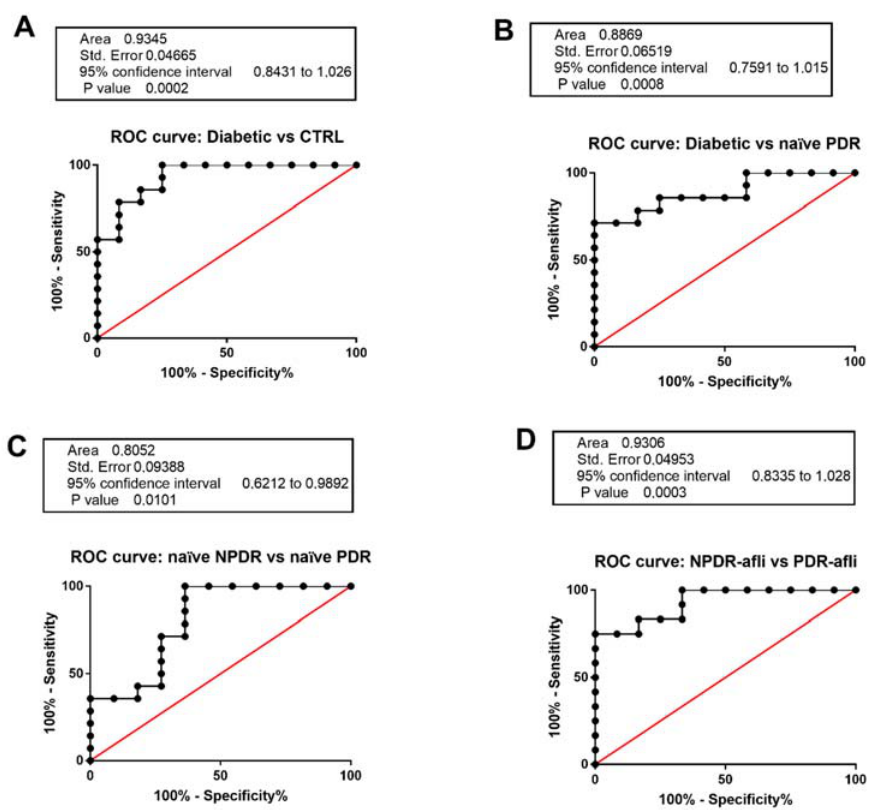
Figure 5. Receiving-operating characteristics curves for TGF β 1 serum levels. C-statistics validated TGF β 1 serum levels as a predictive biomarker of ( A ) diabetic patients without sign of DR (diabetic) compared to control healthy subjects; ( B ) diabetic compared to naïve PDR patients; ( C ) naïve NPDR compared to naïve PDR patients; ( D ) NPDR treated with aflibercept (afli) compared to PDR treated (afli) patients. Table 2. Normality test.